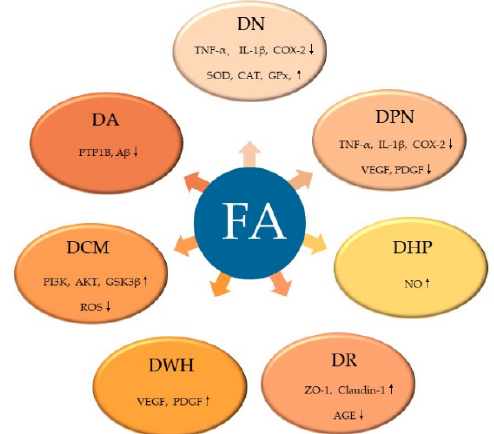
Figure 4. The mechanisms of FA in alleviating hepatic glucose production and improving β -cell function and lipid metabolism during the development of DM. FA, ferulic acid; DM, diabetes mellitus; SOD, superoxide dismutase; CAT, catalase; GPx, glutathione peroxidase; GK, glucokinase; G6Pase, glucose-6-phosphatase; PEPCK, phosphoenolpyruvate carboxykinase; TG, triglycerides; FFA, free fatty acid.